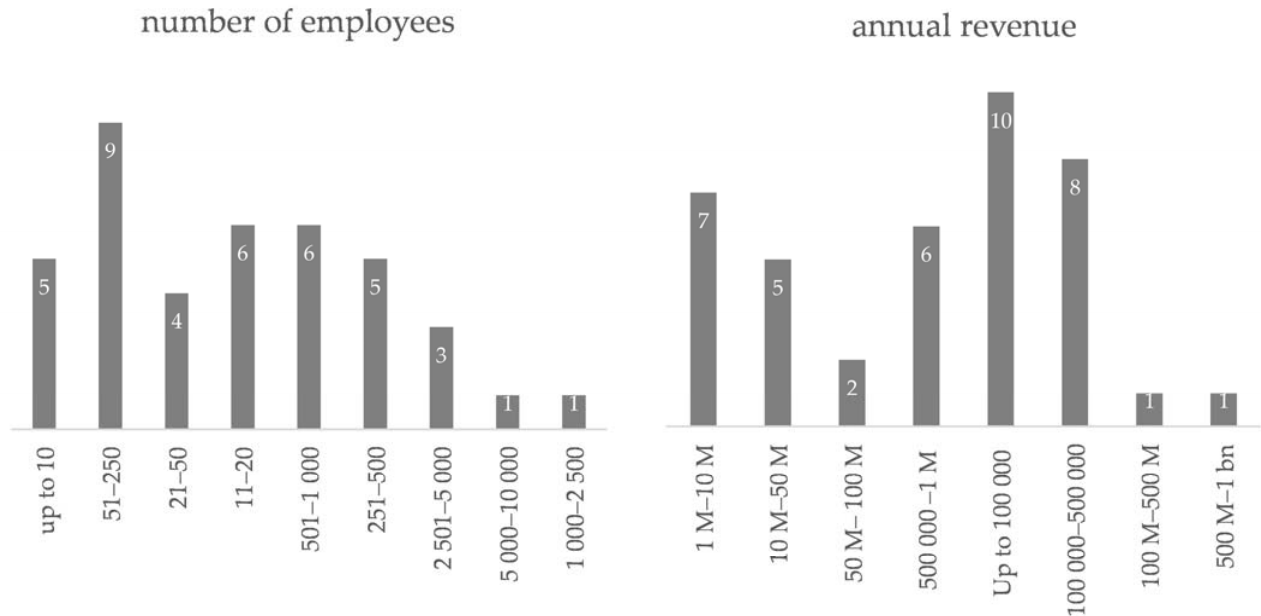
Figure 5. Organisation size by employees and annual revenue in